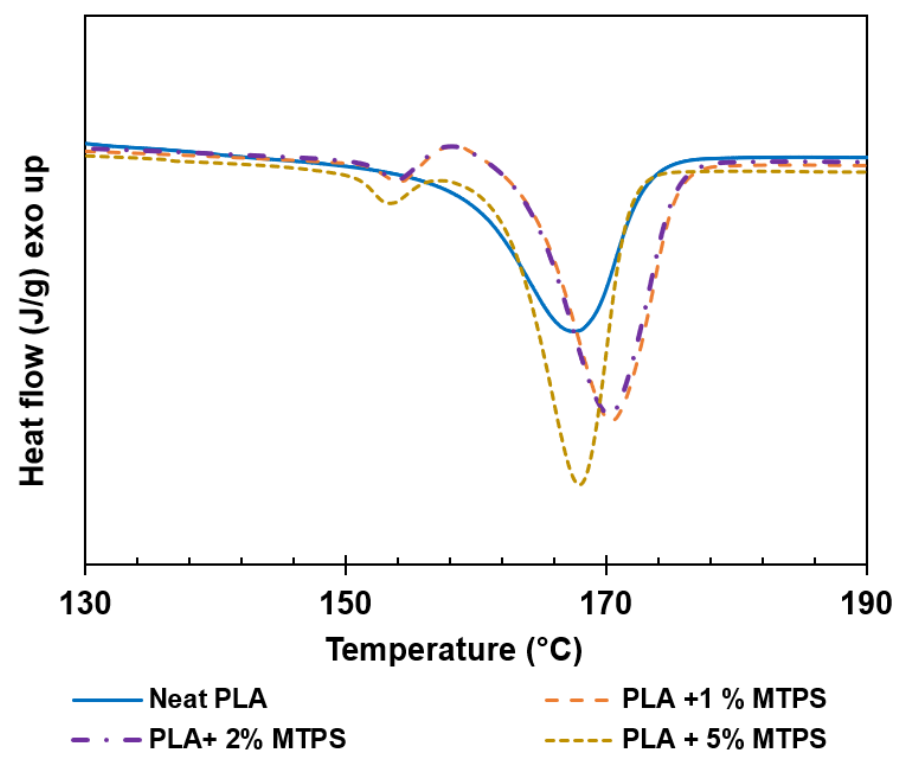
Figure 9. Melting curves for PLA blends after